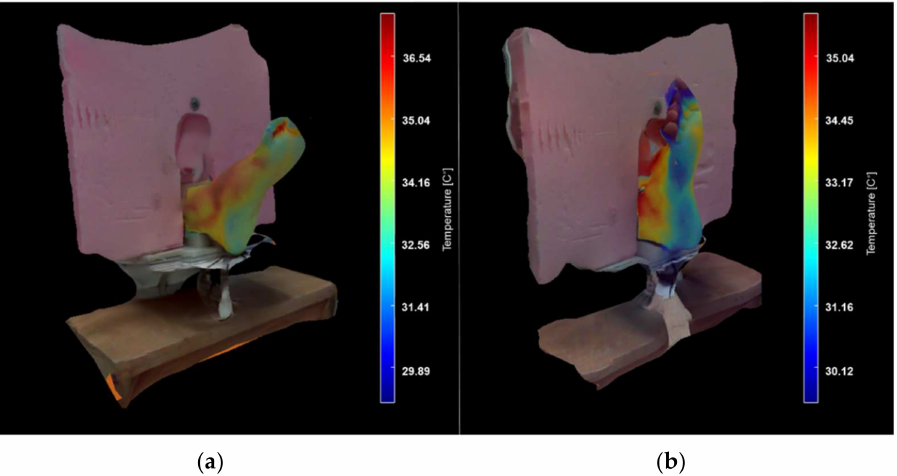
Figure 22. 3D models of the foot in a thermal surface and a visible-light environment. ( a ) Volunteer 1 and ( b ) Volunteer